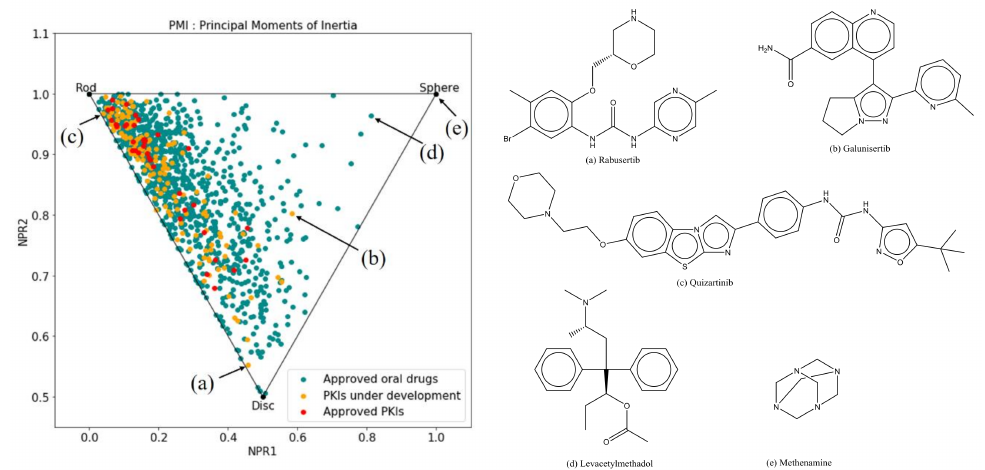
Figure 7. Principal Moments of Inertia (PMI) plot of orally approved drugs (in green) and PKIs (in yellow and red). Compounds a , b and c represent the extreme shape of the PKI dataset. Compounds d and e are the most spherical oral